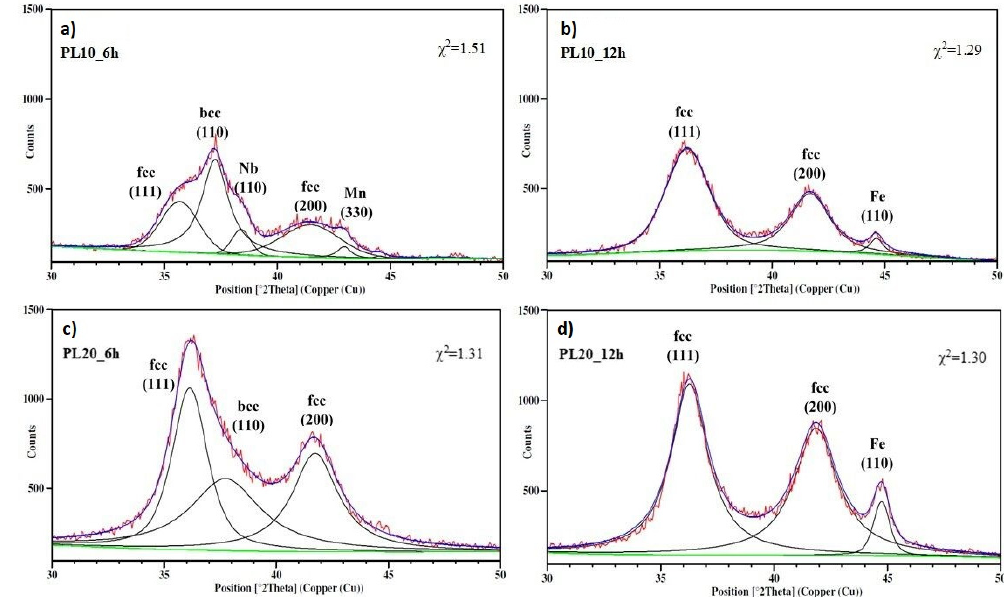
Figure 4. Deconvoluted XRD patterns in the 30 ◦ –50 ◦ 2 θ range, for the PL10_6h ( a ), PL10_12h ( b ), PL20_6h ( c ) and PL20_12h